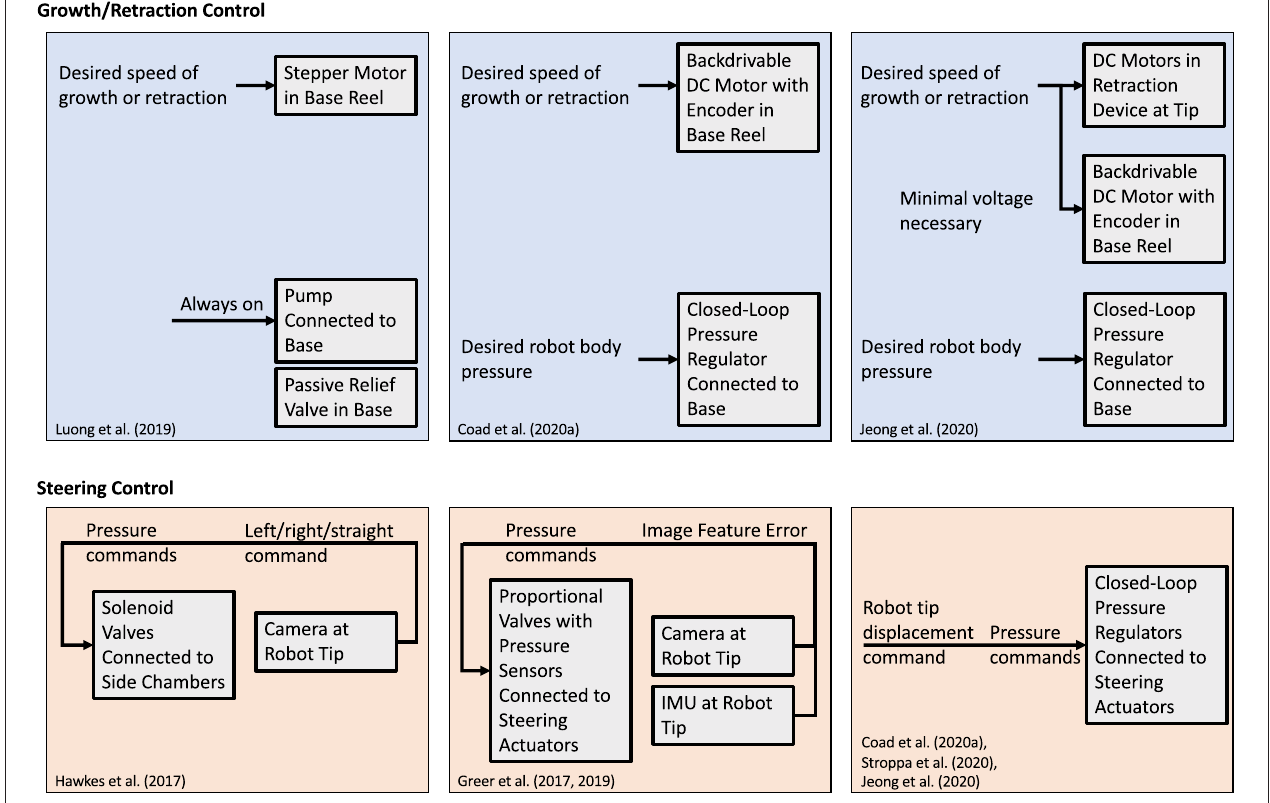
FIGURE 9 | Control schemes for the growth/retraction and the steering degrees of freedom of robot tip movement. (Top) Control of growth and retraction speed is achieved by balancing internal pressure with motor inputs to maintain the proper level of tension in the tail. (Bottom) Steering control is achieved by mapping desired tip displacements to pressures in steering